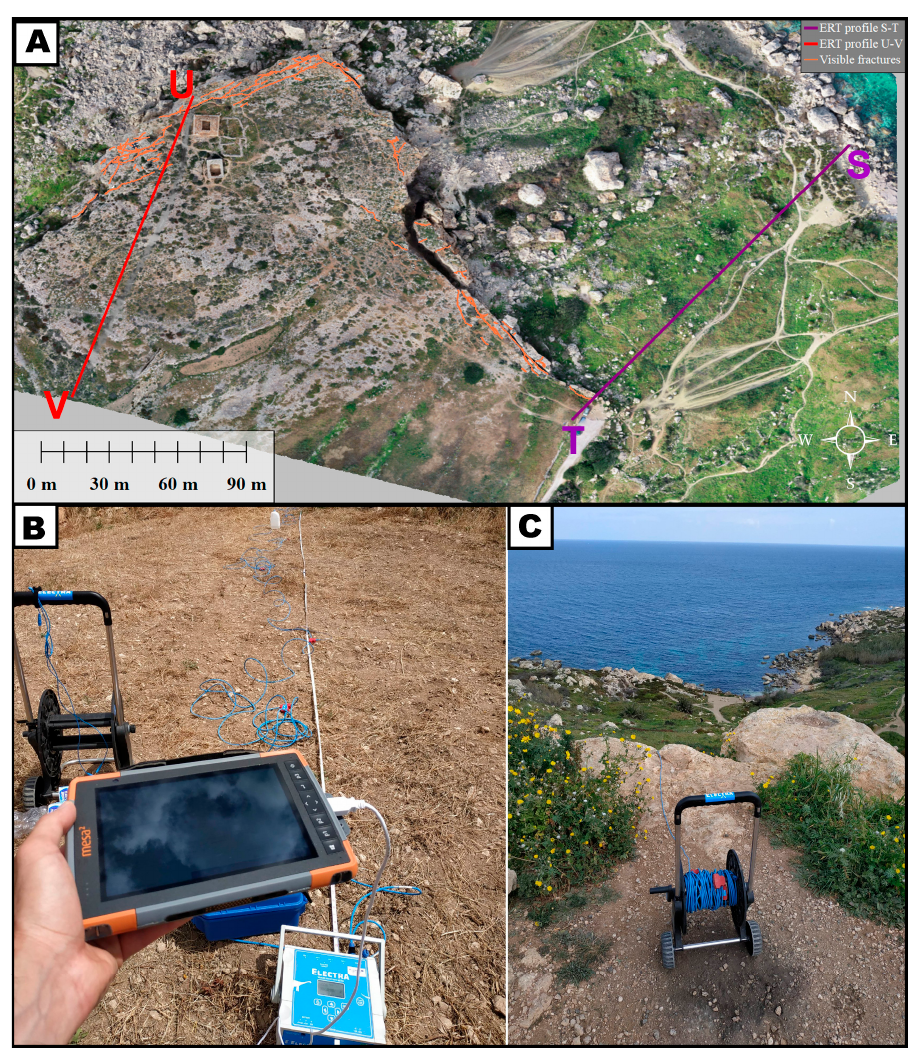
Figure 2. ( A ) Orthomosaic of the study area with the ERT surveys localization carried out on the Selmun promontory. The fractures visible from the surface are highlighted in orange. ( B , C ) Photos of ERT fieldwork.